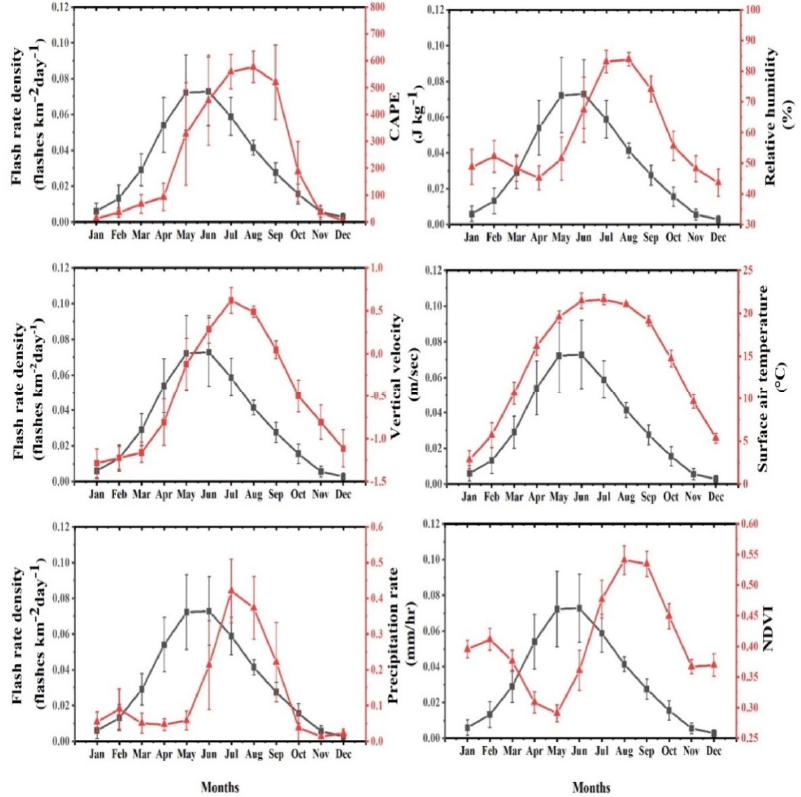
Figure 7. Monthly climatology for averaged values of flash rate density (on the primary Y -axis) with other parameters (on the secondary Y -axis) for the period of 2000–2013 over the study region. Table 1. Pearson correlation coefficients between lightning flash rate density and other parameters for the period of 2000–2013 over the study region for winter, pre-monsoon, monsoon, and